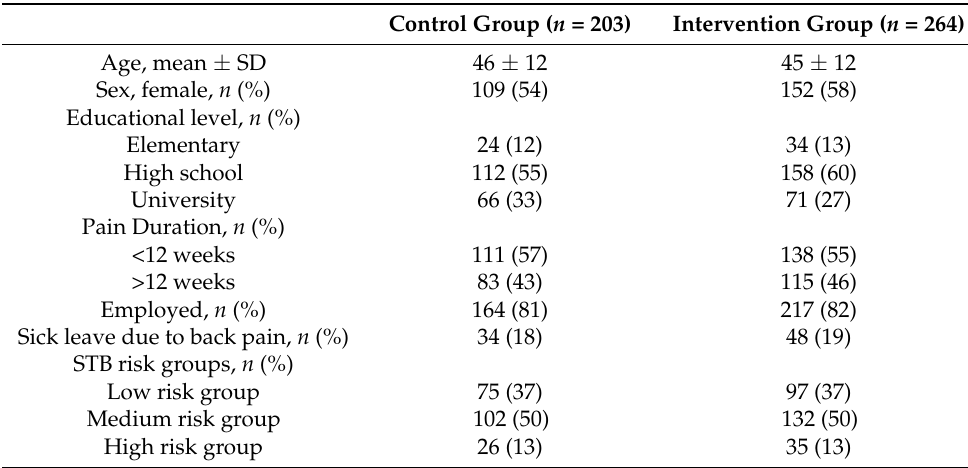
Table 2. Baseline characteristics of the included